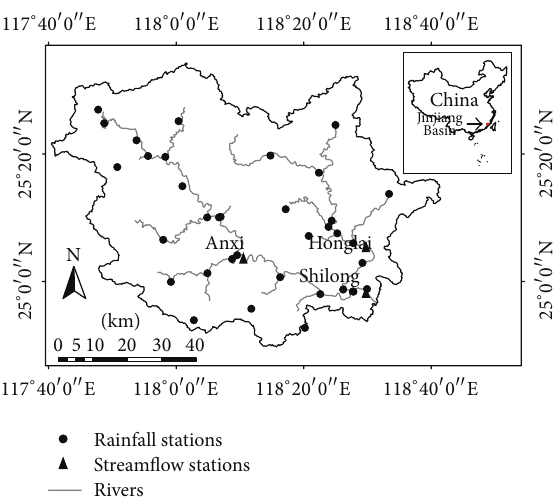
Figure 3: The schematic description of BTOPMC structure for runoff generation at each grid, where 𝑃 is gross precipitation, 𝐼 max is maximum interception capacity, I is interception state, ET 0 is interception evaporation, ET is evapotranspiration from soil water, 𝑆 is maximum root zone storage capacity, 𝑆 is soil water in root r max rz is soil water moving from root zone to gravity drainage zone, 𝑞 rz are soil water deficit and state in gravity drainage zone, SD and 𝑆 uz is overland flow, and 𝑞 is base zone, 𝑞 V is groundwater recharge, 𝑞 o b